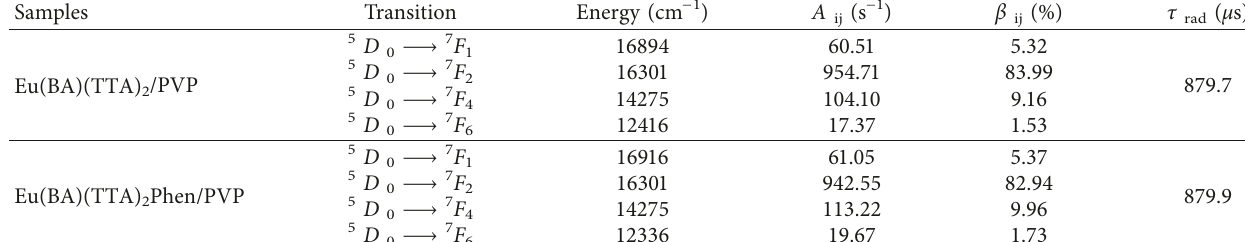
5 D 0 in Eu(BA)(TTA) 2 /PVP